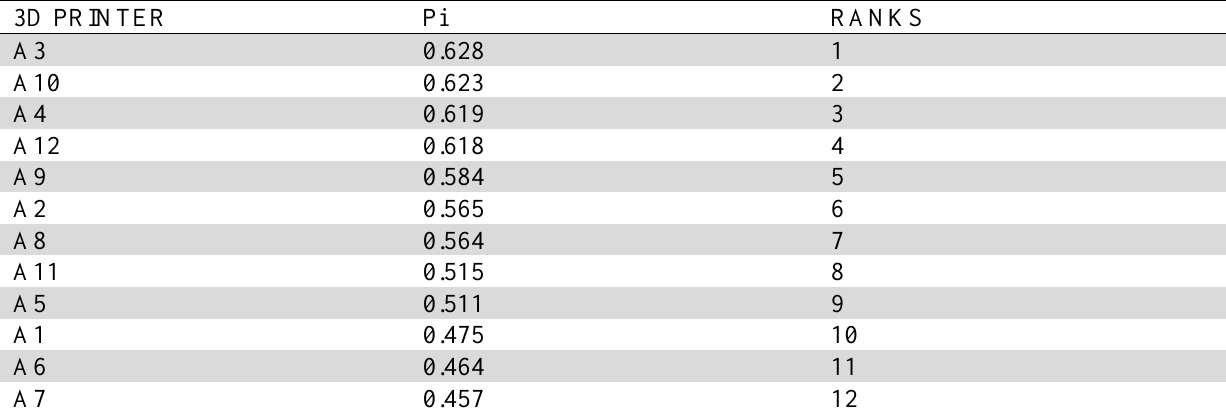
Ranking of 3D printers using similarity based